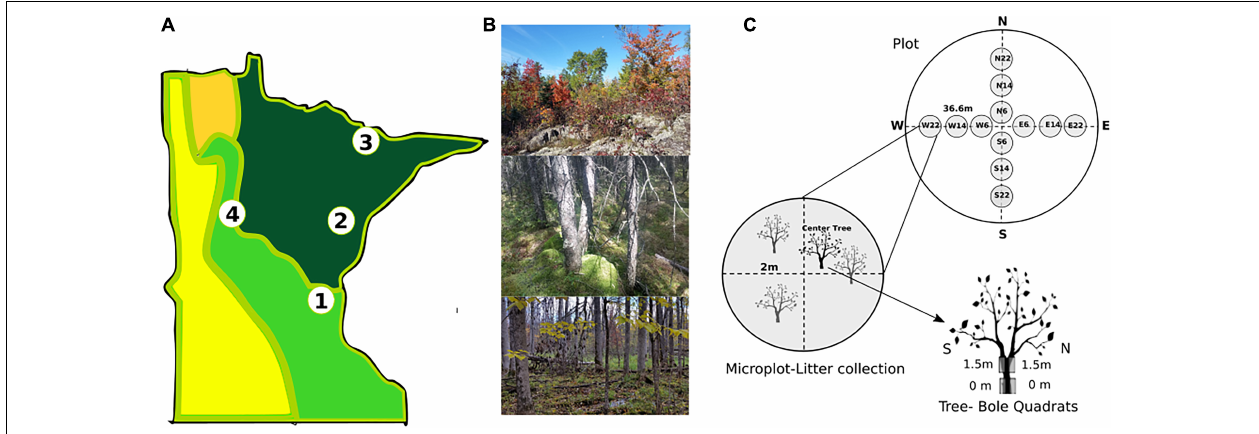
FIGURE 1 | Sampling design at state (A) , site (B) , and plot (C) scales. A-Sites (1-Cedar Creek Ecosystem Reserve, 2-Cloquet Forestry Center, 3-Hubachek Wilderness Research Center, and 4-Itasca State Park) are located across the eastern temperate (light green) to boreal (dark green) forest transition. (B) Within each site plots were selected to represent in forest types (top-Aspen-Birch, middle-Tamarack-Black Spruce bog, and bottom- Black Ash swamp). (C) Each plot includes 2 m-radius microplots for litter collection and 20 cm × 50 cm quadrats at 4 locations on 12 microplot center trees for bole epiphyte sampling. Photo credit: A. Glauser and D.